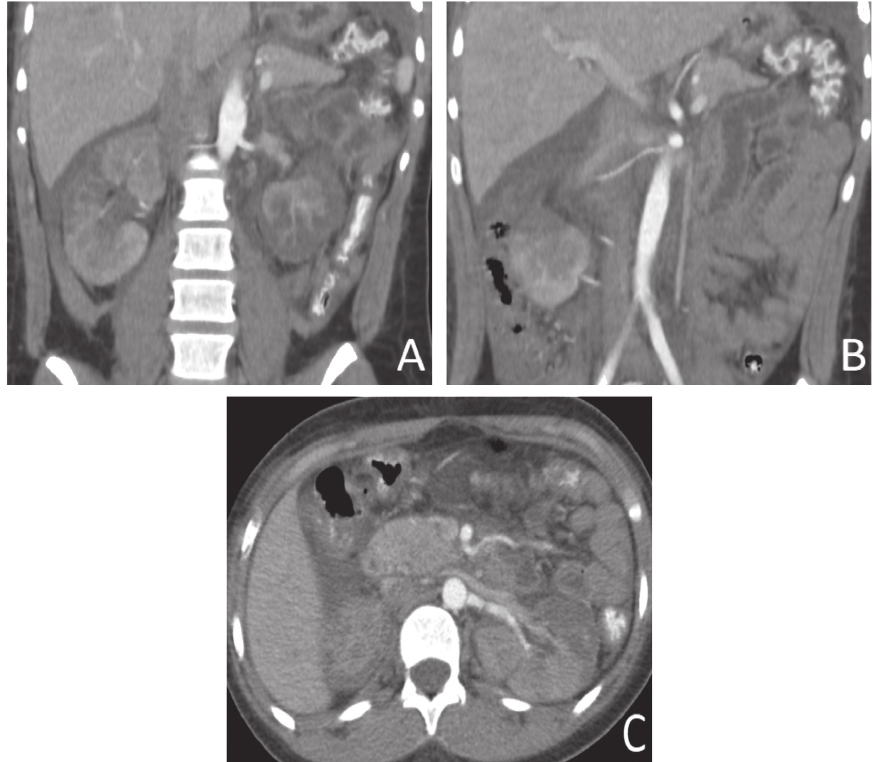
Figure 2: CT scan performed on day 7. (a) Coronal view, arterial phase; renal arteries are both clearly identified, without dissection or thrombosis. (b) Coronal view, arterial phase, 3 right renal arteries, anatomical variant. (c) Axial view, probable unilateral artefact without any flow